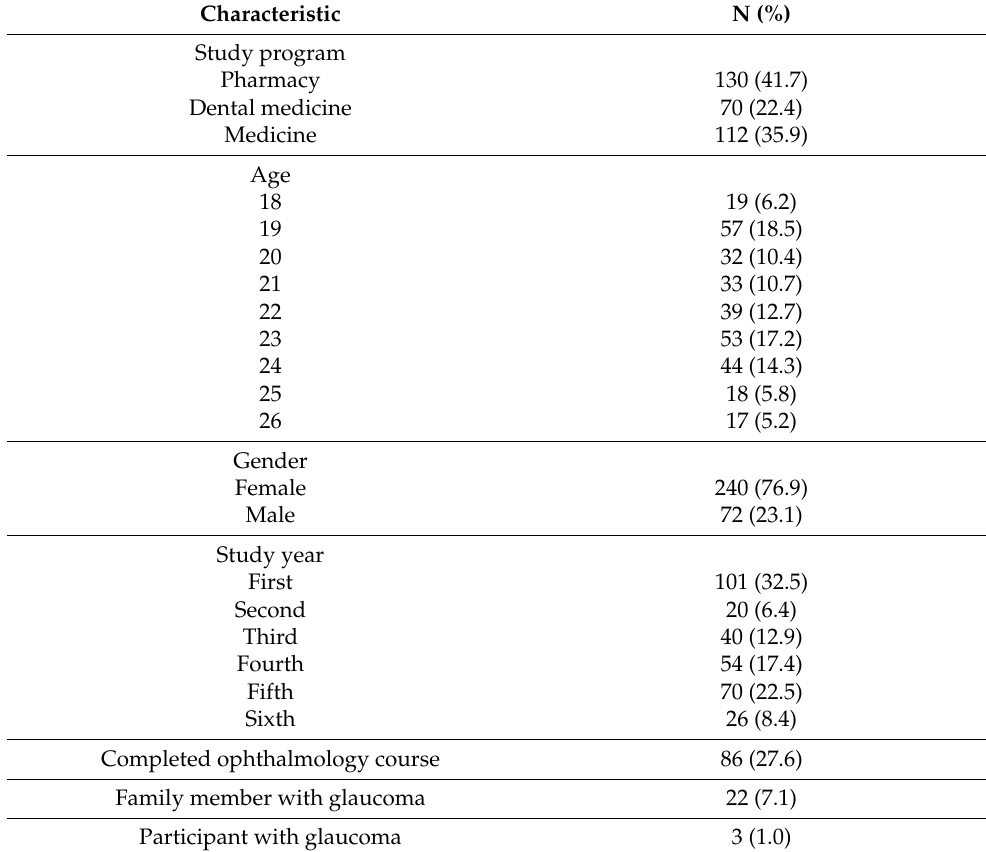
Table 1. Demographic data of study